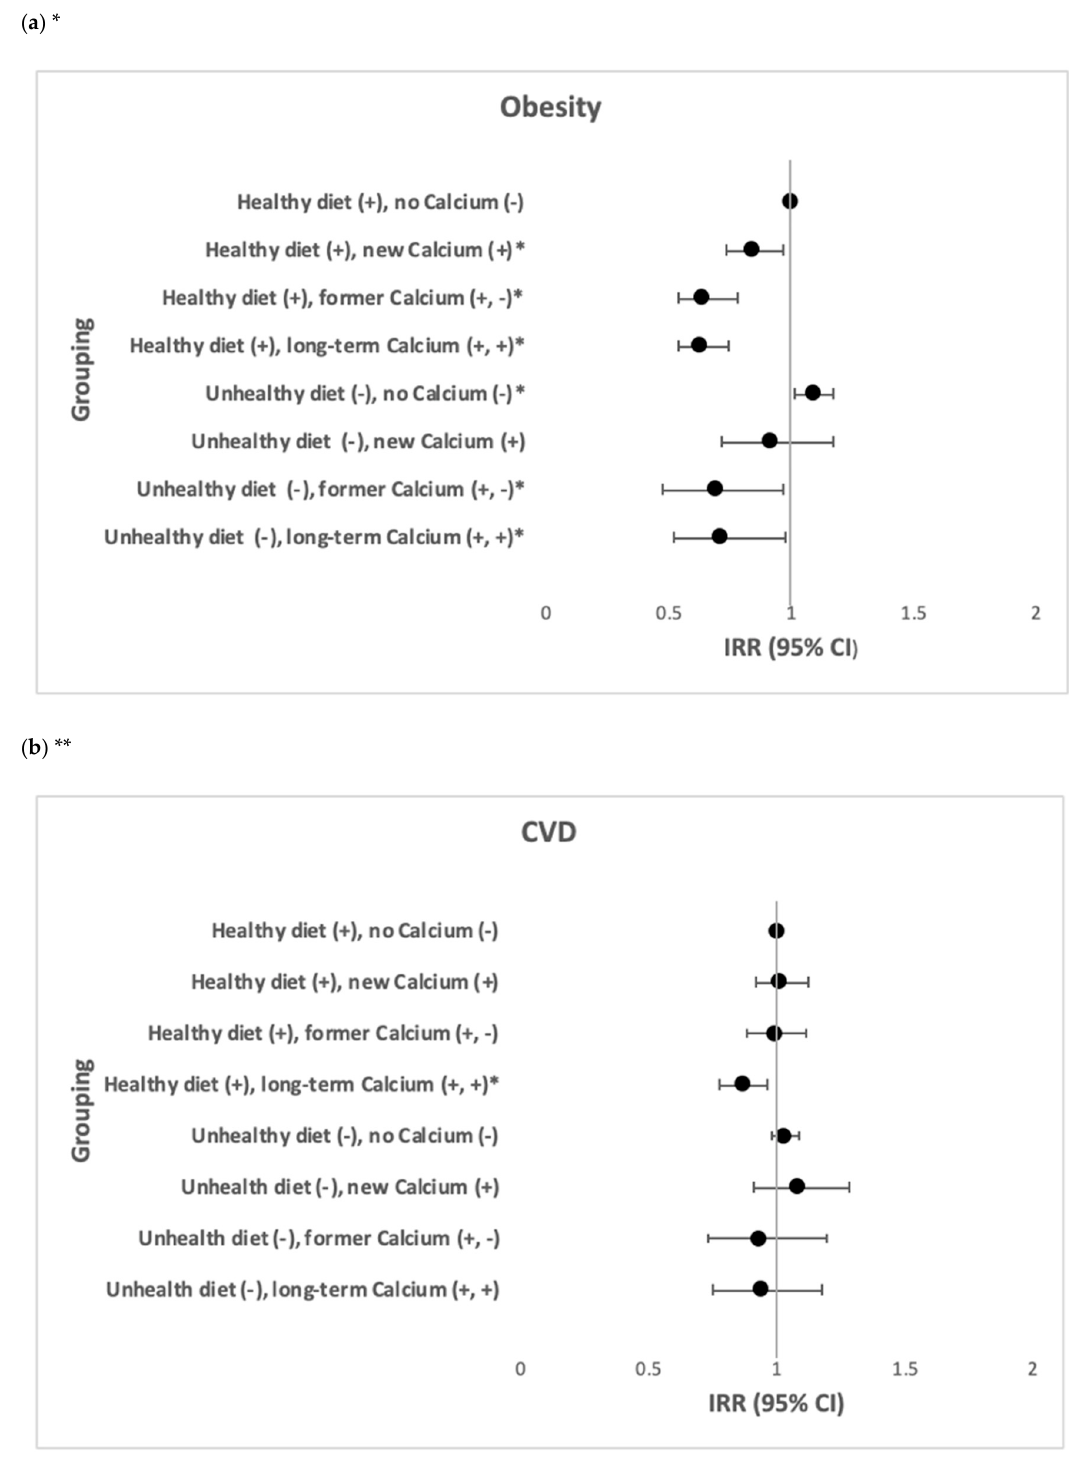
Figure 5. The joint effects of healthy vs. unhealthy diet and calcium consumption in relation to the incidence of obesity and CVD (N = 69,990) *. ( a ) The joint effects of healthy vs. unhealthy diet and calcium consumption in relation to the incidence of obesity. ( b ) The joint effects of healthy vs. unhealthy diet and calcium consumption in relation to the incidence of CVD. * IRR after adjustment of age, gender, country of birth, marital status, education, SEIFA, smoking, physical activity, CVD, diabetes, blood cholesterol and blood pressure. ** IRR after adjustment of age, gender, country of birth, marital status, education, SEIFA, smoking, physical activity, obesity, diabetes, blood cholesterol and blood pressure.